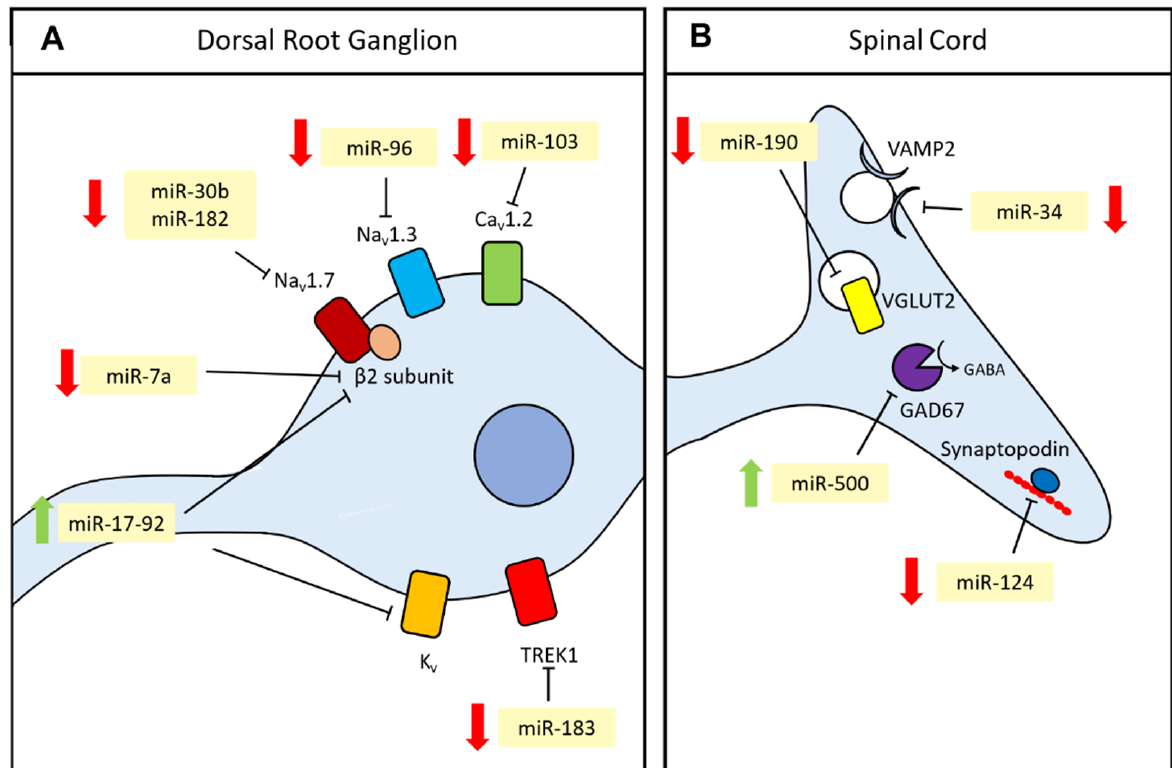
Figure 2. Diagram showing miRNAs dysregulated in neuropathic pain whose targets are directly involved in ( A ) cellular excitability and ( B ) synaptic transmission, verified in animal models. Red downward arrows indicate that the miRNA is downregulated during neuropathic pain, whilst upward green arrows indicate miRNA upregulation in neuropathic pain conditions.